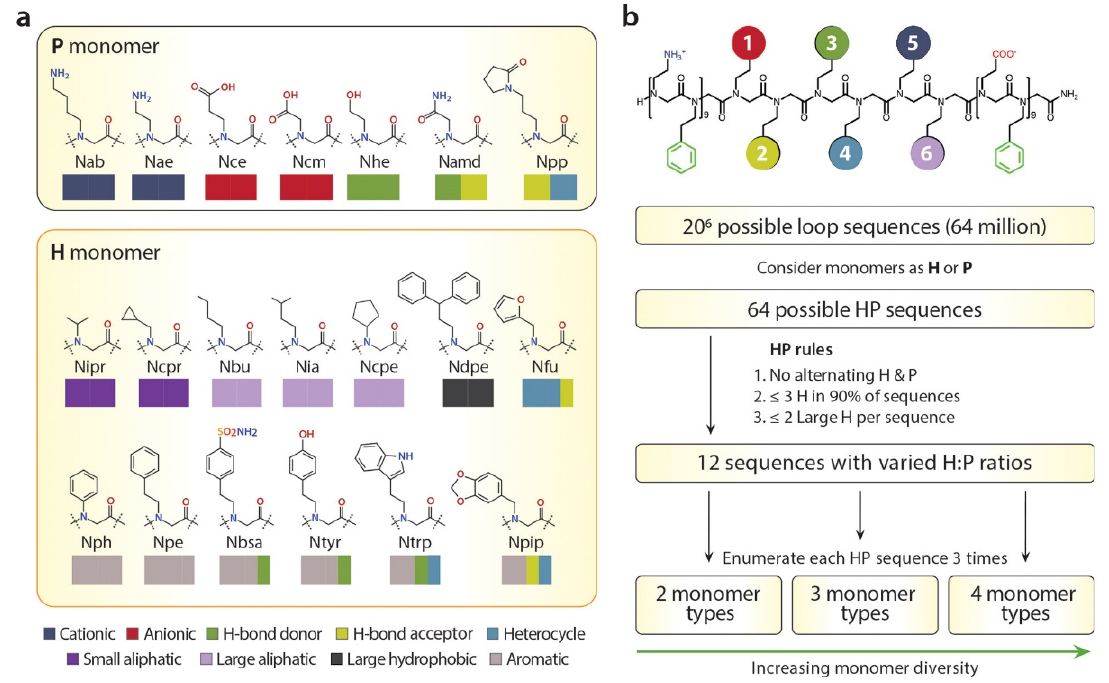
Figure 3. Design of the chemically diverse binding loops, built from a basis of 20 efficiently incor- porated monomers. ( a ) P (hydrophilic) and H (hydrophobic) amine monomers exhibiting various properties. Colored rectangles represent primary and secondary properties of monomers. ( b ) Design algorithm for creating a maximally diverse set of loop insert sequences, while avoiding extremes of hydrophobicity (Adapted from ref. [33]. Copyright 2020, American Chemical Society).